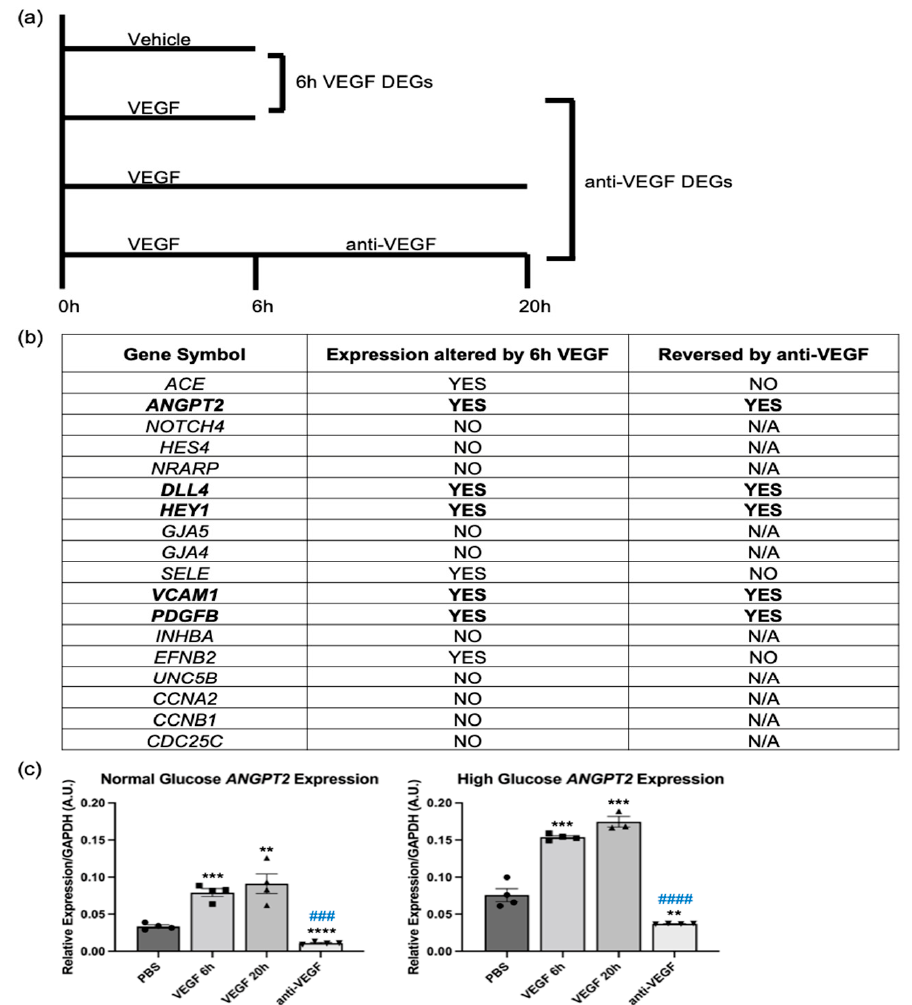
Figure 5. VEGF and anti-VEGF regulated ANGPT2 expression in both euglycemic and hyperglycemic conditions. ( a ) Schematic depicting the treatment conditions of high-glucose HRECs analyzed using RNA-Seq. HRECs were treated with vehicle (PBS), VEGF (2 nM), or anti-VEGF (1 uM) for times listed. ( b ) Chart showing short-term VEGF/anti-VEGF regulation of the 18 vascular homeostasis genes regulated by long-term VEGF/anti-VEGF exposure. ( c ) Quantitative PCR for the expression of ANGPT2 message in normal and high-glucose HRECs treated with vehicle, 6 h VEGF, 20 h VEGF, or 6 h VEGF + 14 h anti-VEGF. ANGPT2 expression was normalized to GAPDH and presented as relative expression. Similar results are observed in three independent experiments. Data are expressed as mean ± SD. The difference in means between two groups was analyzed using Student’s t -test where ** p < 0.01, *** p < 0.001, and **** p < 0.0001 and ### p < 0.001, #### p < 0.0001 vs. 20 h VEGF. n = 4 wells per